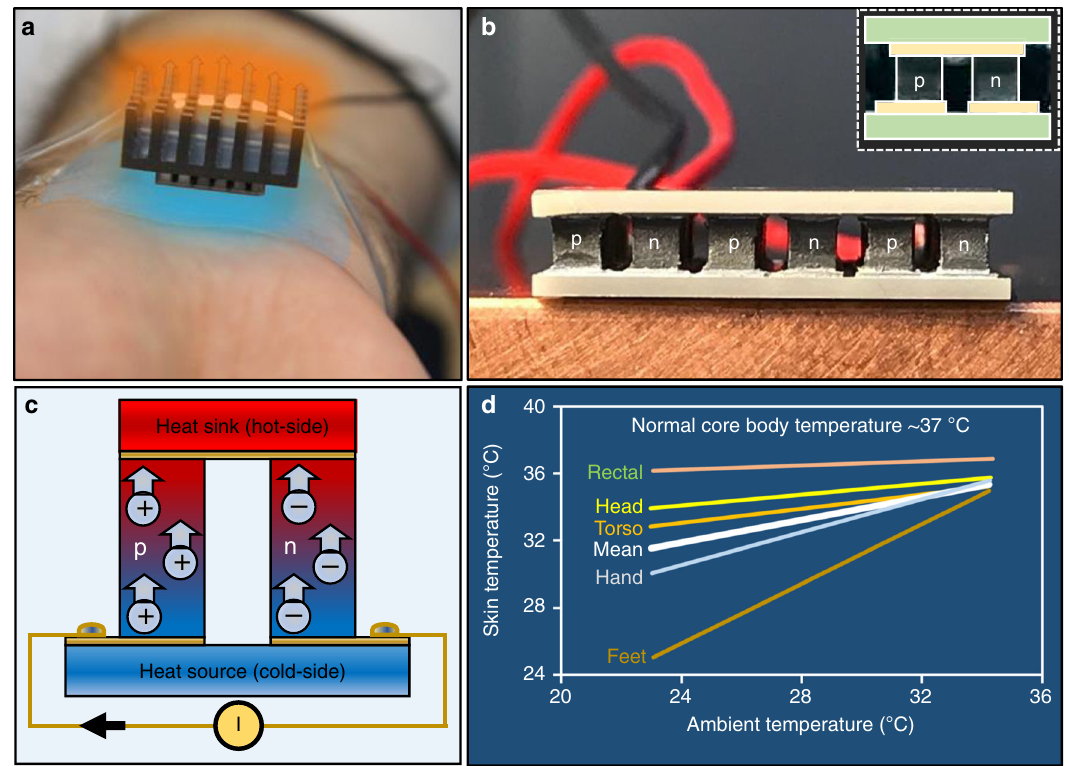
Fig. 1 Personalized cooling using wearable TE modules. a Wearable thermoelectric cooler (TEC) module provides localized body cooling, thereby making space cooling unnecessary. Arrows illustrate heat fl ow from human body to the ambient via TEC and heat sink. b TECs consist of several thermocouples, comprising of p- and n-type thermoelectric legs, connected electrically in series and thermally in parallel. c Upon applying the electric current, charge carriers, holes in p-type and electrons in n-type legs, carry heat from one side of the module to the other, thereby allowing heat exchange with the TEC module and the surroundings. Arrows illustrate movement of charge carriers, whereas circles with positive and negative signs depict holes and electrons, respectively. d The human skin temperature varies at different parts of body and increases with increase in ambient temperature. Information taken from ref. 41 . By natural evolution, human skin is poor conductor of heat and so is the ambient air. The wearable TECs, therefore, operate in an extremely